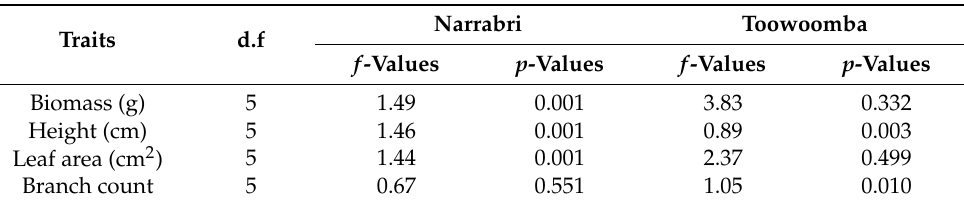
Table 4. Analysis of variance for 4 traits of faba bean cultivars tested at two locations.